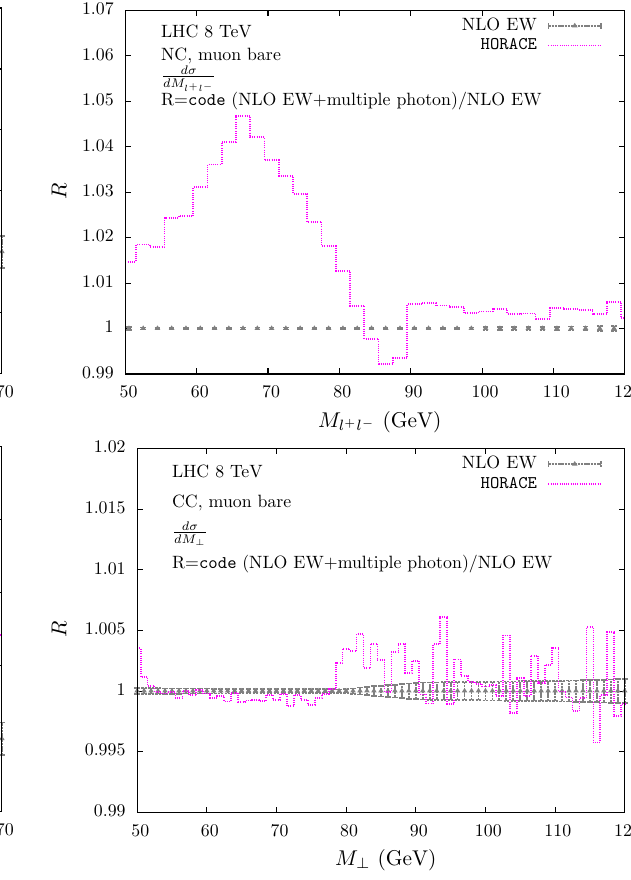
Fig. 30 Relative effect of higher-order ( O (α 2 ) and higher) EW cor- rections in pp → μ + μ − + X ( upper plots ) and pp → μ + ν μ + X ( lowerplots ),duetomultiple-photonradiationmatchedtotheNLOEW results, expressed in units of the pure NLO EW calculation evaluated in the benchmark setup for bare muons. Shown are the lepton trans- verse momentum in NC DY ( upper left ), lepton-pair invariant mass in